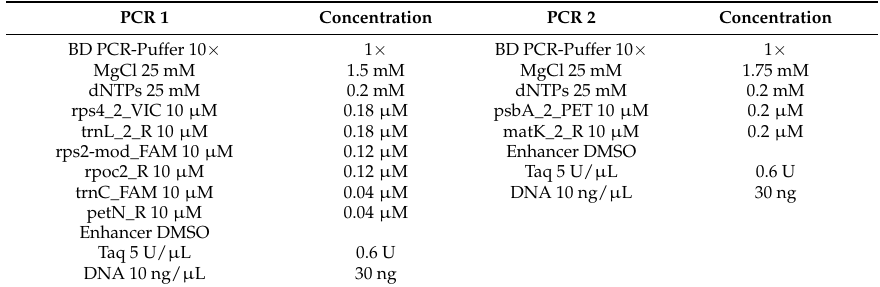
Table 6. Multiplex PCR for the amplification of four cp regions to be analyzed on the ABI3730 Genetic Analyzer.